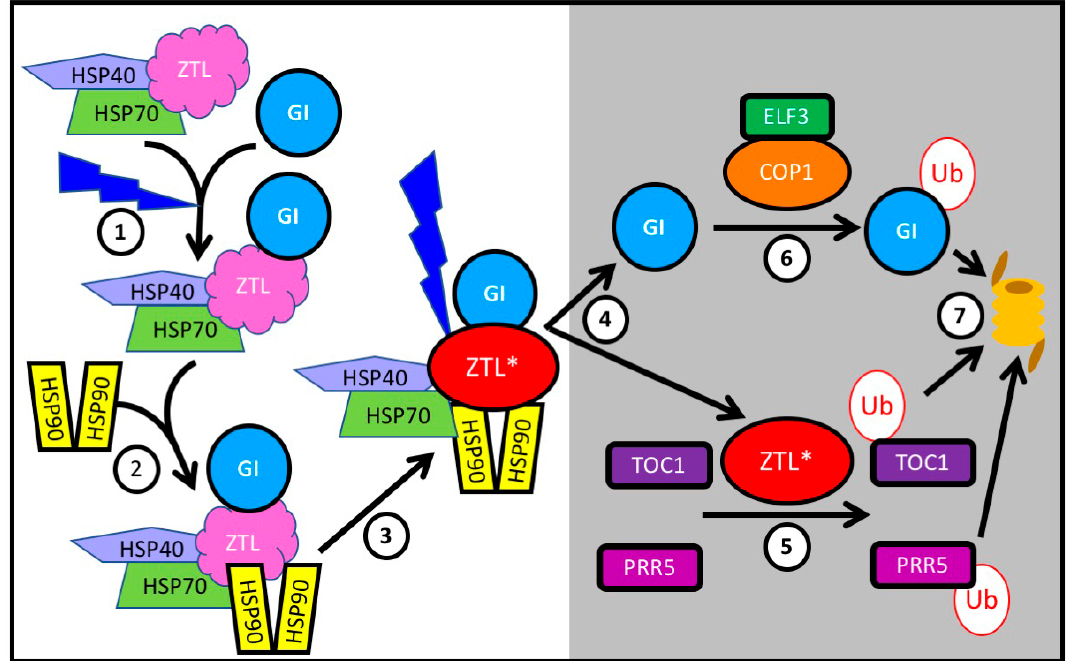
Figure 2. GI is a co-chaperone interacting with HSP90 to facilitate the maturation of ZTL, which is released after dark to ubiquitylate TOC1 and PRR5, targeting them for proteasomal degradation. ① Immature ZTL interacts with HSP70 (and probably HSP40). The recruitment of GI to this complex is facilitated by blue light. ② Subsequently HS90 homodimers are recruited to this complex. ③ GI plays a role as co-chaperone in the maturation of ZTL, here indicated as ZTL*. Blue light stabilizes the interaction of GI with ZTL, sequestering it from its targets TOC1 and PRR5. ④ After dusk, ZTL is released from GI and ⑤ ubiquitylates TOC1 and PRR5, targeting them for proteasomal degradation ⑦ . ⑥ Free GI is itself ubiquitylated by a complex of COP1 with ELF3, and ubiquitylated GI is degraded by the proteasome ⑦ .